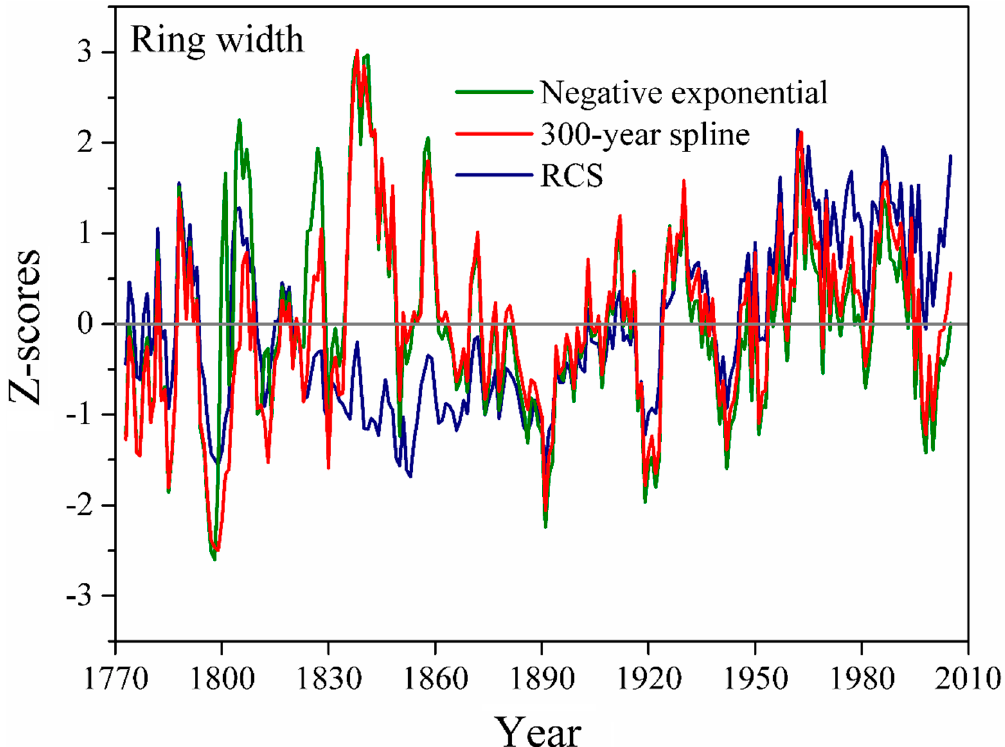
Figure 3. The EXP—negative exponential (green), RCS—regional curve standardization (blue), and SPL-300-year splines (red) chronologies from AD 1773 to 2005.